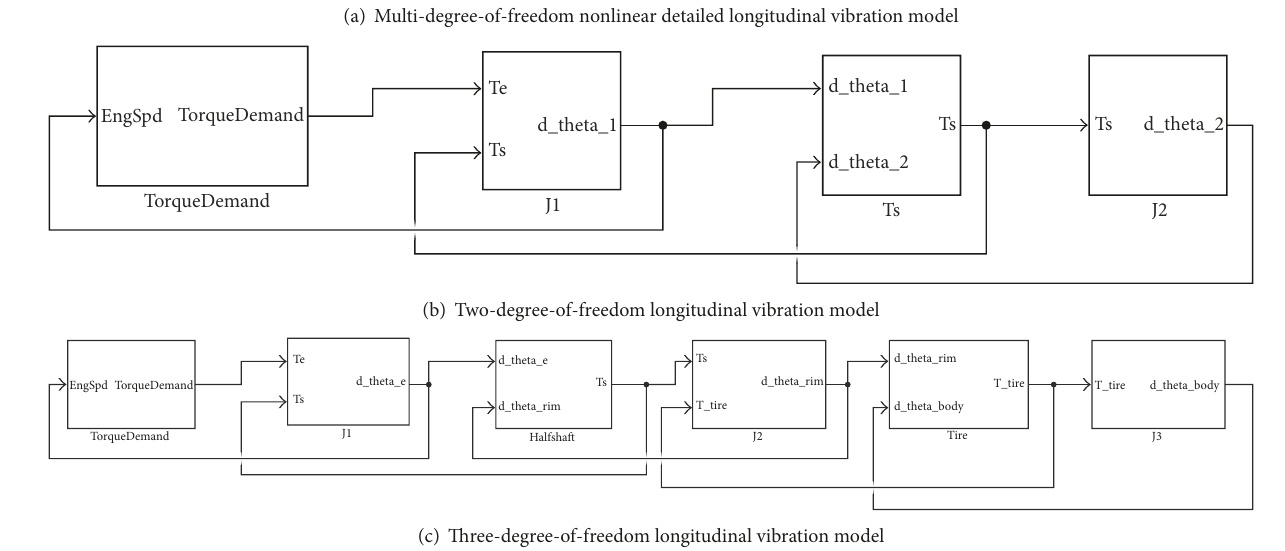
(c) Three-degree-of-freedom longitudinal vibration model Figure 23: Vehicle longitudinal vibration model in